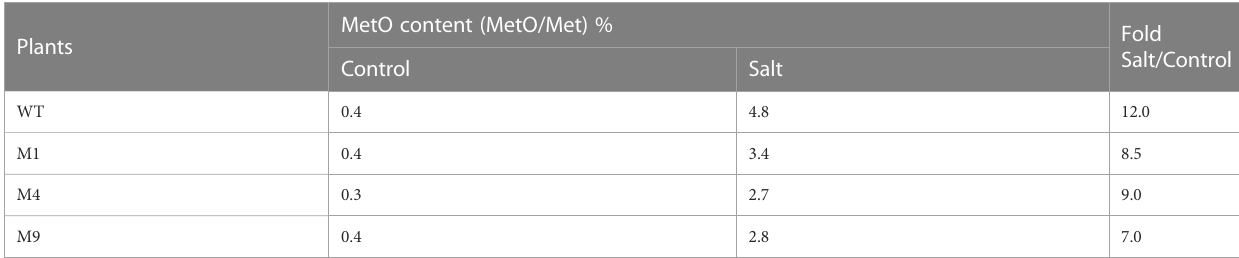
TABLE 2 Analysis of oxidized methionine (MetO) content in wild-type (WT) and transgenic AtMSRB5 (M1, 4, 9) rice plants with or without 250 mM NaCl treatment.